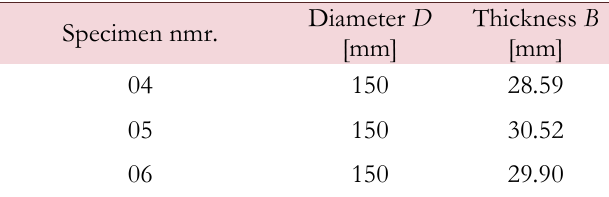
Table 1: Dimensions of Brazilian disc